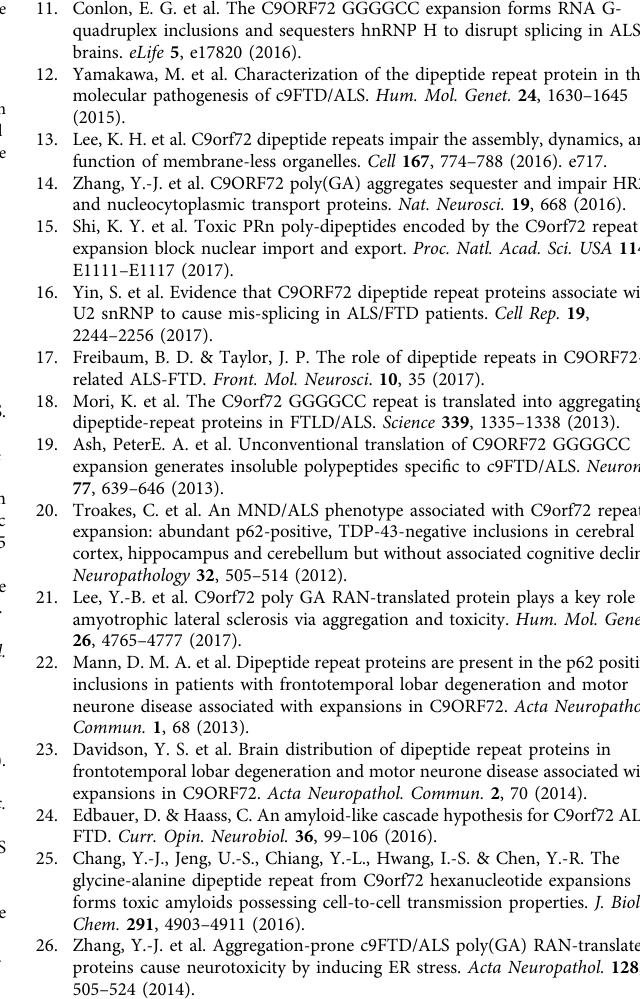
Fig. 6 GA DPRs induces TDP-43 cytosolic retention and causes severe damage to the mouse cortical neurons. a Representive immuno fl uorescence of endogenous TDP-43 (Green) in neuroblastoma SH-SY5Y after ADP-1 treatment (1 μ M), photoinitiated, and then incubated for 24h. Yellow arrows indicate the cells with TDP-43 cytosolic retention. Scale bars indicate 10 µ m. b Quanti fi cation analysis of SH-SY5Y cells with TDP-43 cytosolic retention. Three biological replicates were carried out ( r = 3). More than 32 cells were counted and analyzed in each groups ( n ≥ 32). Mean and standard deviation for + ADP-1 + UV = 57.2± 6.5; + ADP-1 − UV = 20.4 ± 5.4; − ADP-1 + UV = 18.6 ± 7.3; − ADP-1 − UV = 17.9 ± 6.3. *** indicates statistical signi fi cance where p value < 0.001 (analyzed by two-sided Welch ’ s T test with Bonferroni correction, test statistic in group comparison betwen + ADP-1 + UV and − ADP-1 − UV: p value = 0.0005, degree of freedom = 4, t value = 2.78; group compariosion betwen + ADP-1 − UV and − ADP-1 – UV: p value = 0.21, degree of freedom = 4, t value = 2.77; group compariosion betwen − ADP-1 + UV and − ADP-1 – UV: p value = 0.30, degree of freedom = 4, t value = 2.77), and n.s. indicates not signi fi cant. c Representative immuno fl uorescence images of 21DIV mouse cortical neurons stained with antibody against β -III-tubulin (red) and TDP-43 (green) treated with or without 1 μ M ADP-1 and/or 2 min of UV irradiation. The mouse cortical neurons were further incubated for 24 h after ADP-1 treatment and/or UV irradiation. The DNA counter stain DAPI (blue) was included to identify the location of the nucleus. Scale bar indicates 10 µ m. d Quanti fi cation analysis of degeneration area in 21DIV mouse cortical neurons. The degeneration area percentage (%) of neuron is quanti fi ed as fragemnted neurite area/total nerutite area. Three biological replicates were carried out ( r = 3). Mean and standard deviation for + ADP-1 + UV = 36.8 ± 8.8; + ADP-1 − UV = 14.5 ± 5.5; − ADP-1 + UV = 14.4 ± 3.9; − ADP-1 − UV = 12.9 ± 5.0. ** indicates statistical signi fi cance where p value < 0.01 (analyzed by two-sided Welch ’ s T test with Bonferroni correction, test statistic in group compariosion betwen + ADP-1 + UV and − ADP-1 − UV: p value = 0.0086, degree of freedom = 3, t value = 3.18; group compariosion betwen + ADP-1 − UV and − ADP-1 – UV: p value = 0.24, degree of freedom = 4, t value = 2.77; group compariosion betwen − ADP-1 + UV and − ADP-1 – UV: p value = 0.234, degree of freedom = 4, t value = 2.77), and n.s. indicates not signi fi cant. e Quanti fi cation analysis nuclear-to-cytoplasmic ratio of TDP-43 in mice cortical neurons. Three biological replicates were carried out ( r = 3) and counted neuron number ( n ) in each group: + ADP-1 + UV = 86; + ADP-1 − UV = 55; − ADP-1 + UV = 52; − ADP-1 − UV = 56. Mean and standard deviation for + ADP-1 + UV = 1.75 ± 0.05; + ADP-1 − UV = 2.62 ± 0.42; − ADP-1 + UV = 2.49 ± 0.79; − ADP-1 − UV = 2.66 ± 0.19. ** indicates statistical signi fi cance where p value < 0.01 (analyzed by two-sided Welch ’ s T test with Bonferroni correction, test statistic in group compariosion betwen + ADP-1 + UV and − ADP-1 − UV: p value = 0.005, degree of freedom = 2, t value = 4.30; group compariosion betwen + ADP-1 − UV and − ADP-1 – UV: p value = 0.299, degree of freedom = 3, t value = 3.18; group compariosion betwen − ADP-1 + UV and − ADP-1 – UV: p value = 0.248, degree of freedom = 2, t value = 4.30), and n.s. indicates not signi fi